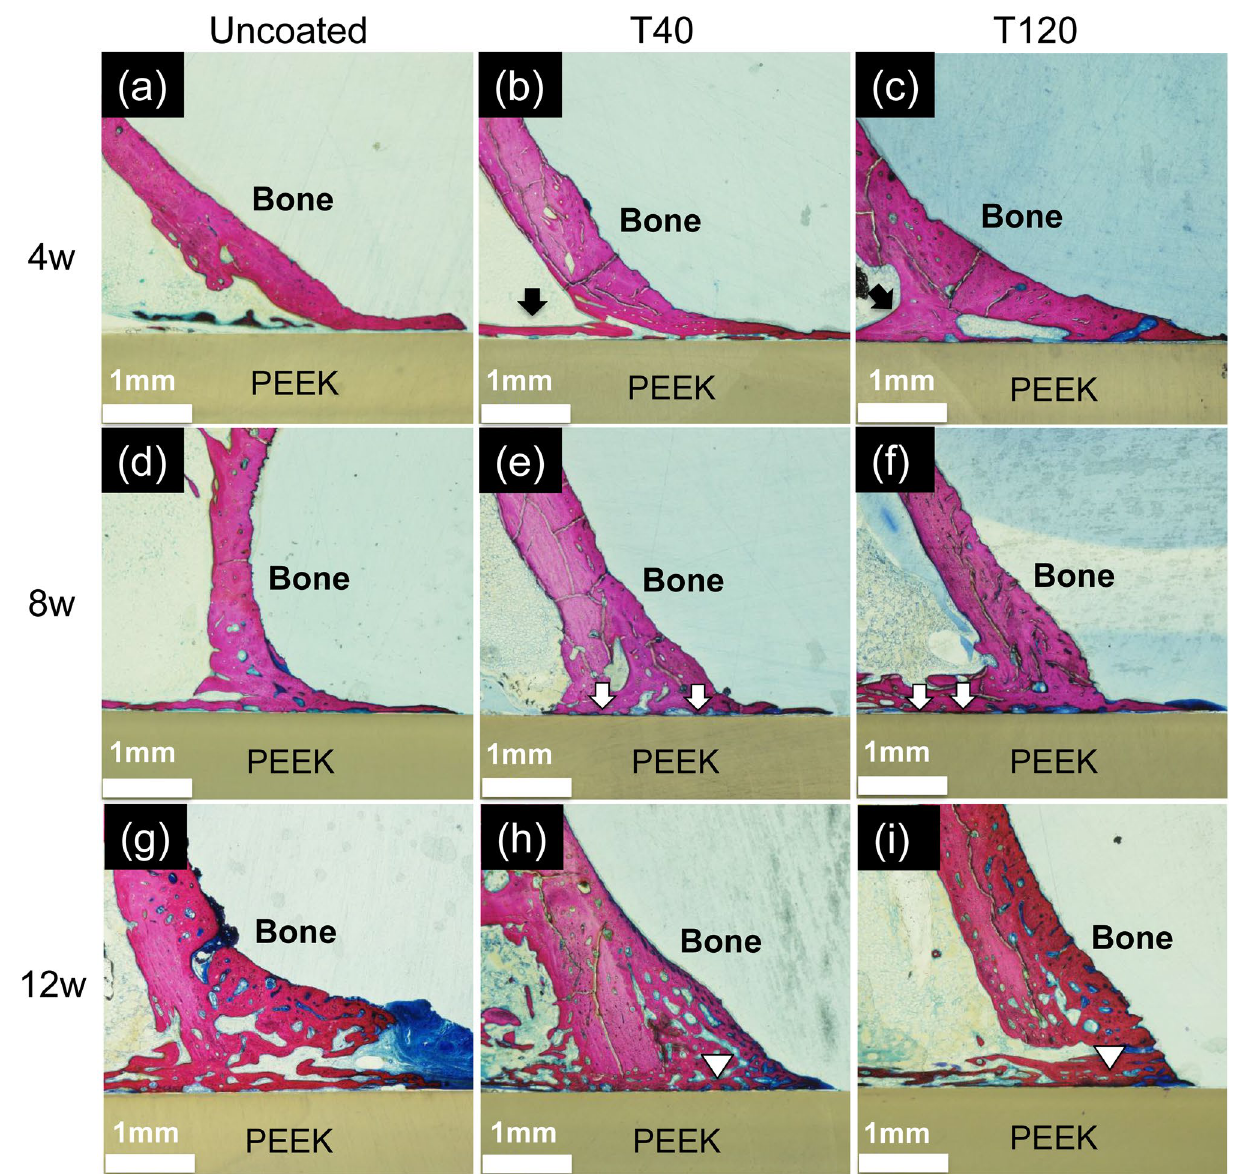
Figure 4. Histological images: ( a ) new bone formation (black arrows) was observed surrounding the T40 and T120 implants at 4 weeks, contrary to the uncoated implant. At 8 weeks, T40 and T120 exhibited direct contact between the new bone tissue and the PEEK surface (white arrows). At 12 weeks, the new bone had evolved into mature bone in the T40 and T120 implants, and extended contact with the PEEK surface was observed (white